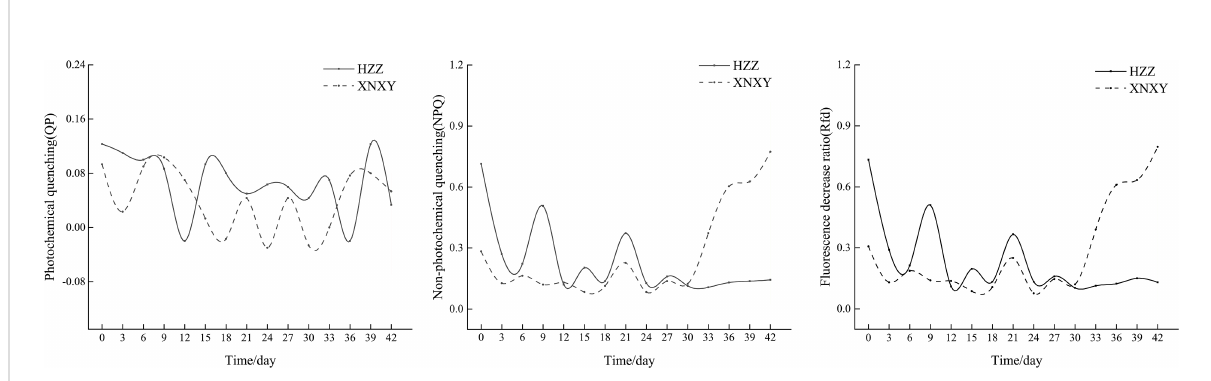
FIGURE 2 Changes in chlorophyll fl uorescence parameters of 'Xiangnong Xiangyun' and 'Hei Zhenzhu' during low temperature culture. ‘ XNXY ’ stands for ‘ Xiangnong Xiangyun ’ , ‘ HZZ ’ stands for ‘ Hei Zhenzhu ’